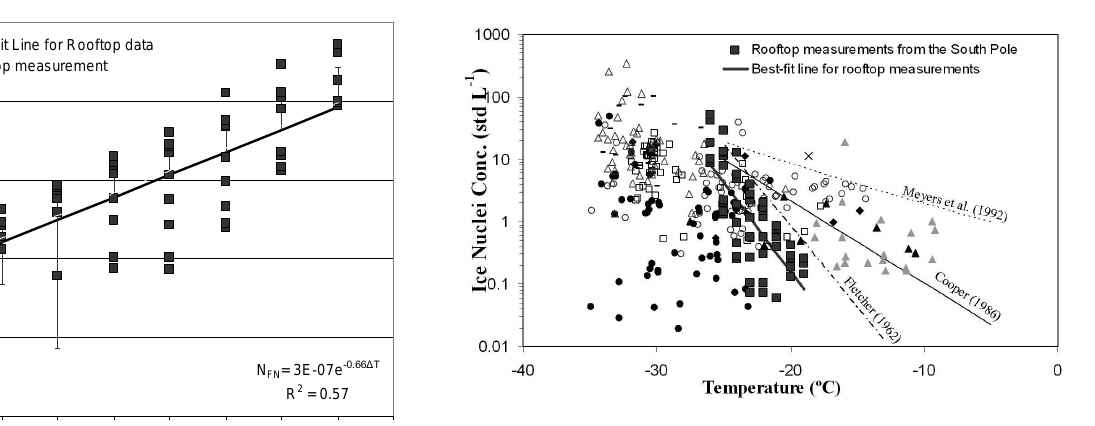
Fig. 11: Ice nuclei concentrations as a function of temperature from DeMott et al (2010) with the present measurements shown in black squares. Fig. 11. Ice nuclei concentrations as a function of temperature from DeMott et al. (2010) with the present measurements shown in black